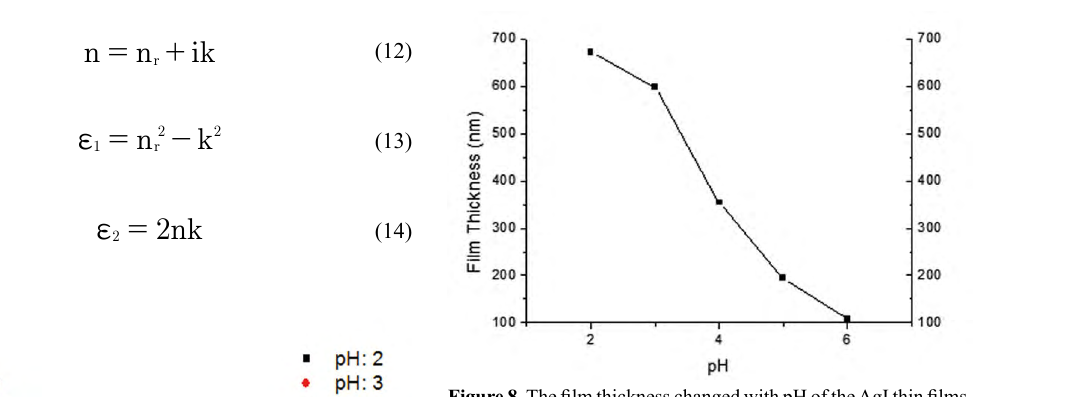
Figure 8. The film thickness changed with pH of the AgI thin films.